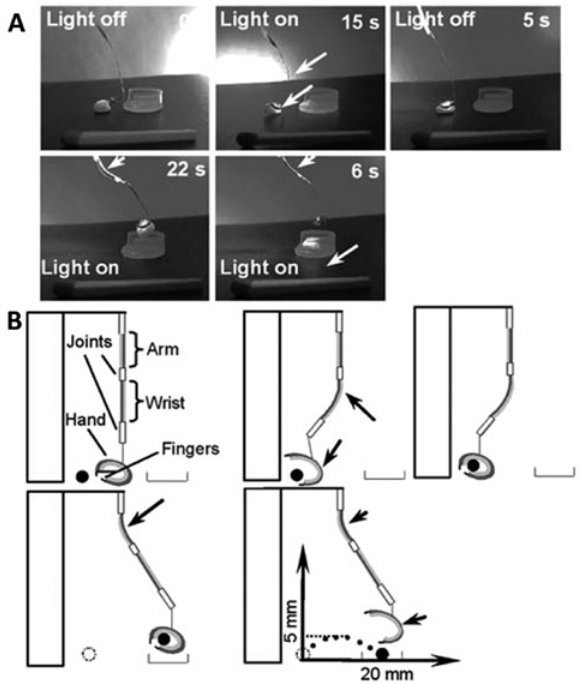
Figure 25: Robotic photo-actuated LCE arm. (A) Photographs of the robotic arm manipulating an object weighing 10 mg. (B) Schematic illustrations of the actions of the robot shown in (A). Reproduced from Ref. [333] with permission from the Royal Society of